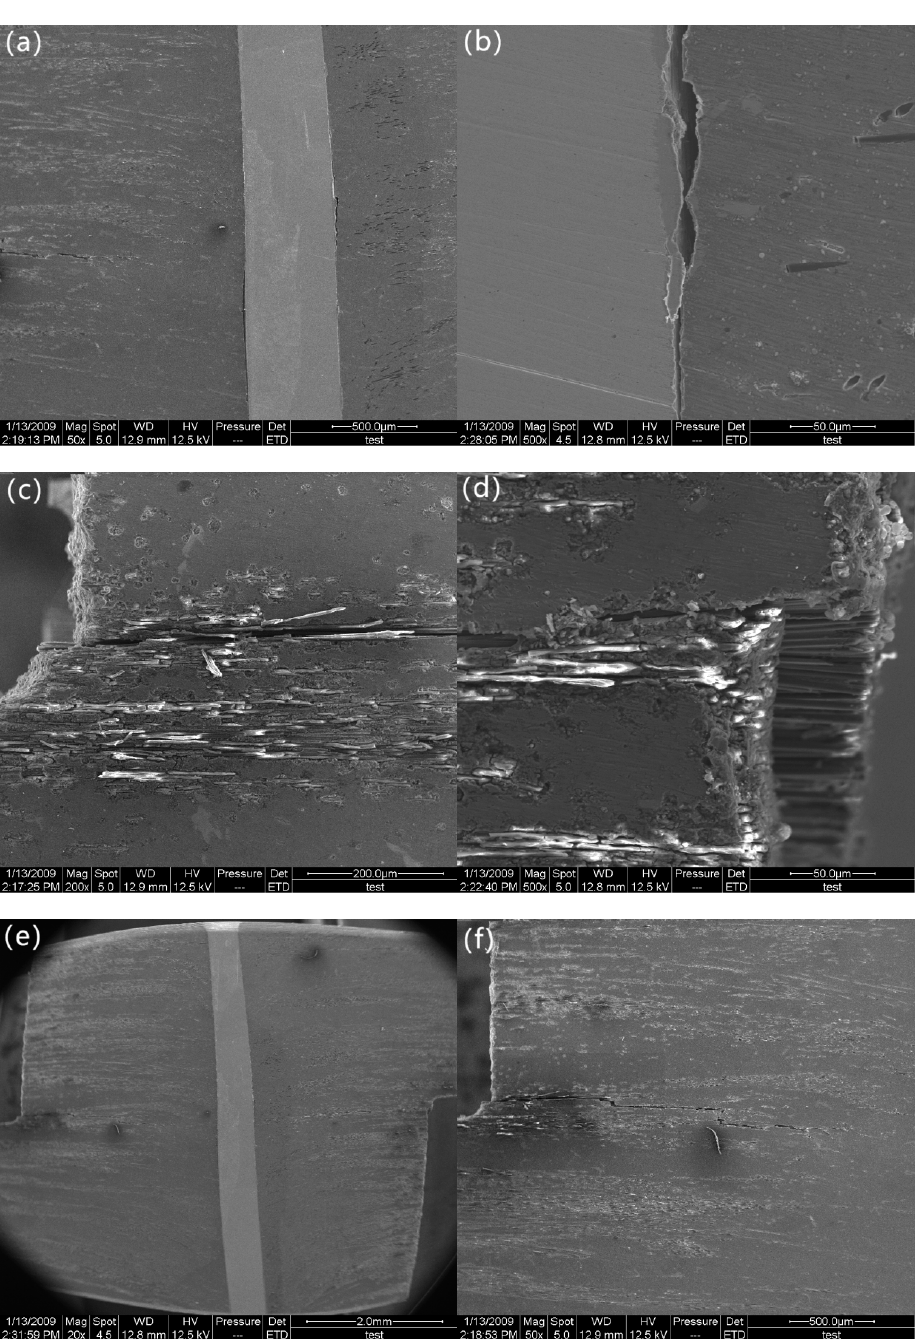
Figure 5. Morphology of the specimen after delamination initiates: ( a ) partial debonding at low magnification, ( b ) partial debonding at high magnification, ( c ) the notch at low magnification, ( d ) the notch at high magnification, ( e ) delamination crack growth at low magnification, and ( f ) delamination crack growth at high magnification.